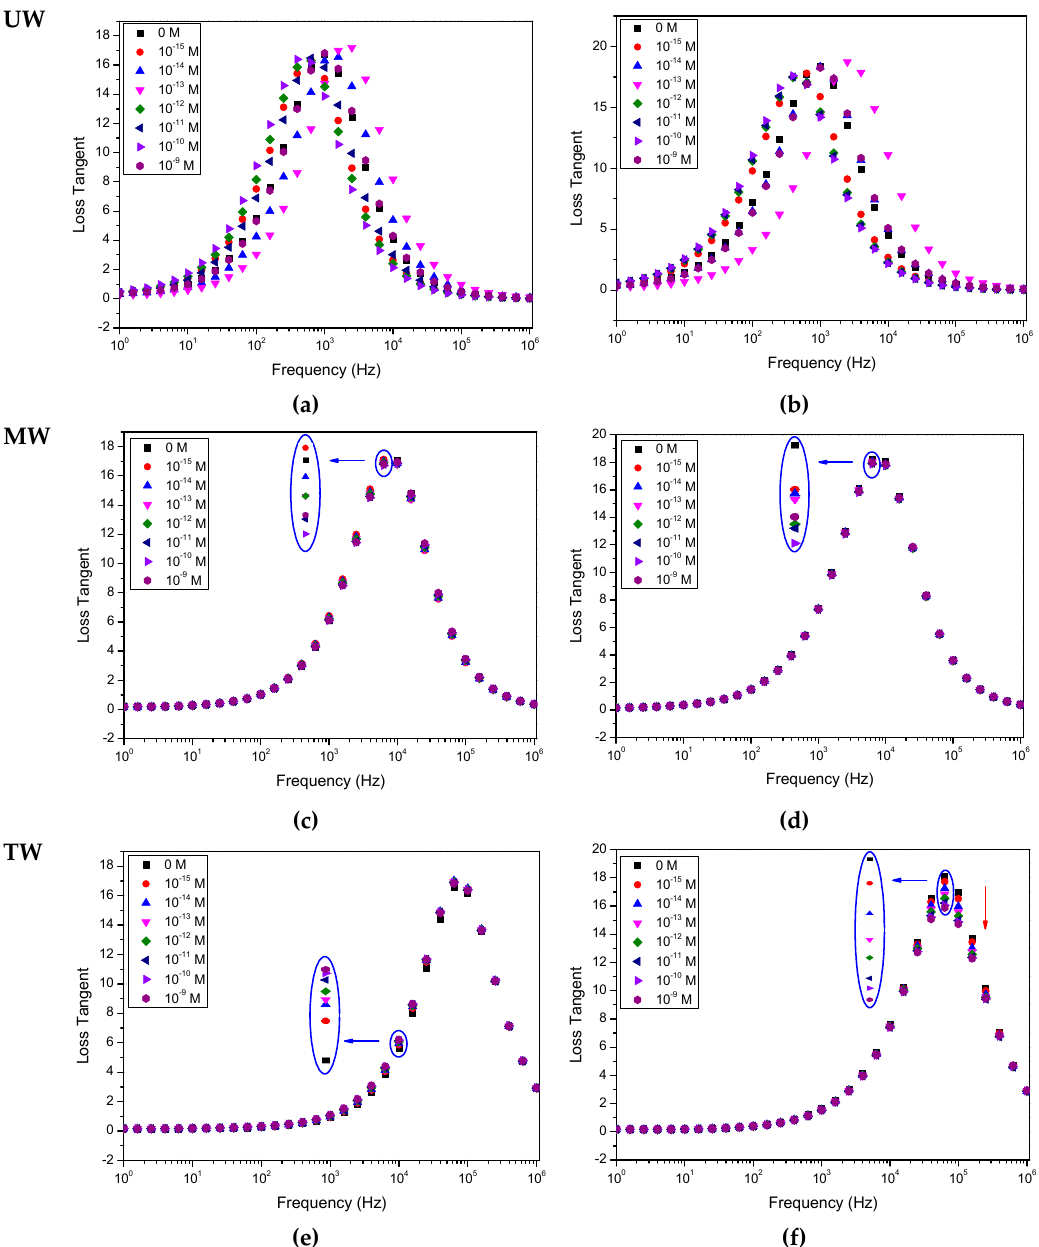
Figure 3. Loss tangent spectra of the sensor devices when immersed in water solutions spiked with different EE2 concentrations: ( a ) uncoated IDE in UW, ( b ) IDE coated with (PEI/PSS) 5 film in UW, ( c ) uncoated IDE in MW, ( d ) IDE coated with (PEI/PSS) 5 film in MW, ( e ) uncoated IDE in TW, ( f ) IDE coated with (PEI/PSS) 5 film in TW. Relative error is less than 1%.